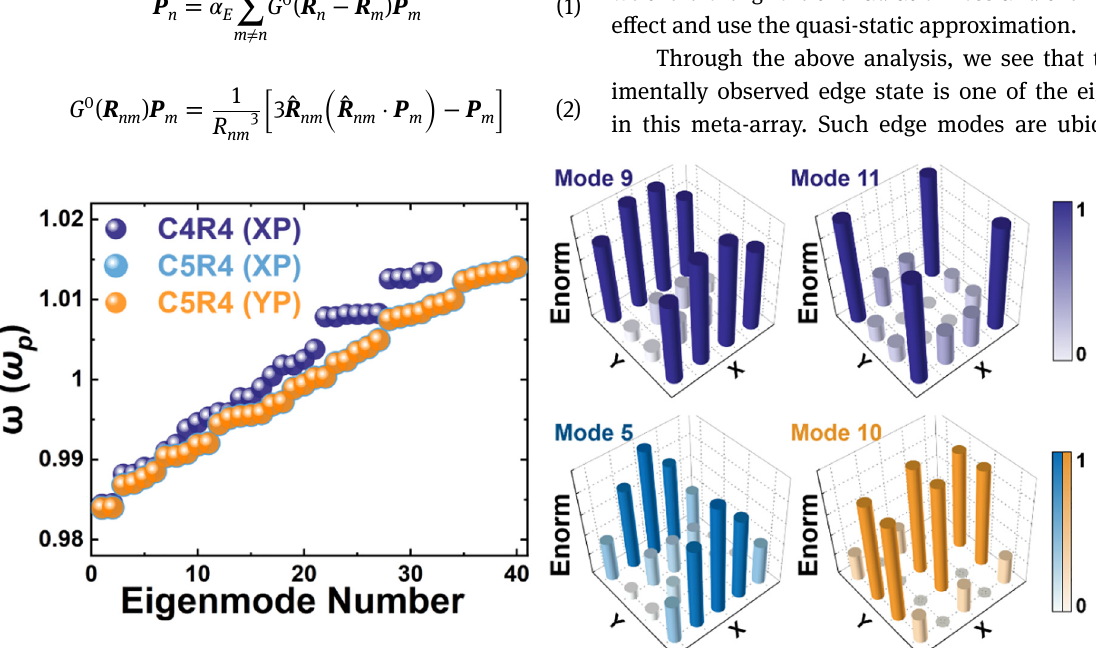
Figure 3: Calculated the eigenvalues of the C4R4 (purples) and C4R5 (blues and oranges) arrays under XP and YP excitation using the model in the text. The normalized electric field distribution of edge state (mode 9 in purple and mode 5 in blue), corner state (mode 11 in purple) and bulk state (mode 10 in